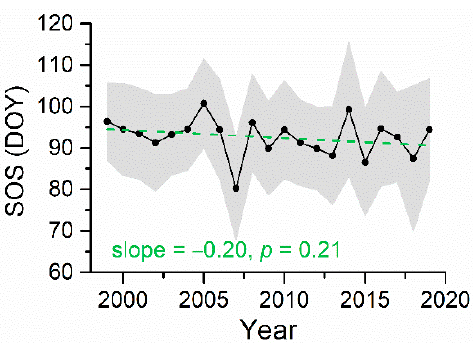
Figure 5. Interannual variation in the regional mean SOS from 1999 to 2019. The grey band represents one standard deviation of the SOS.